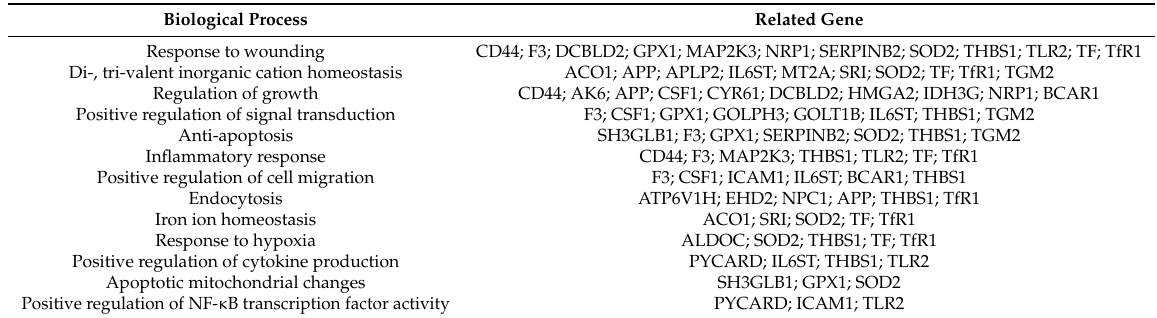
Table 2. Differentially expressed proteins involved in various iron overload-induced biological process in HH4